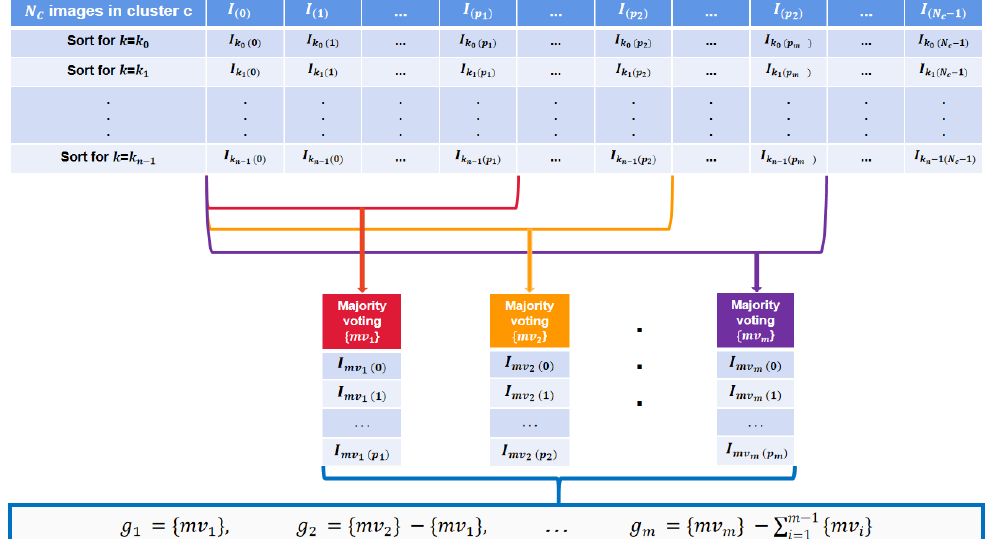
Figure 1. Schematic of the robust majority voting technique (also see Algorithm 1). The first row is the N c image samples in a cluster c . The following n rows are samples sorted for n different choices of k . Majority voting is then applied to group the samples based on the following procedure.